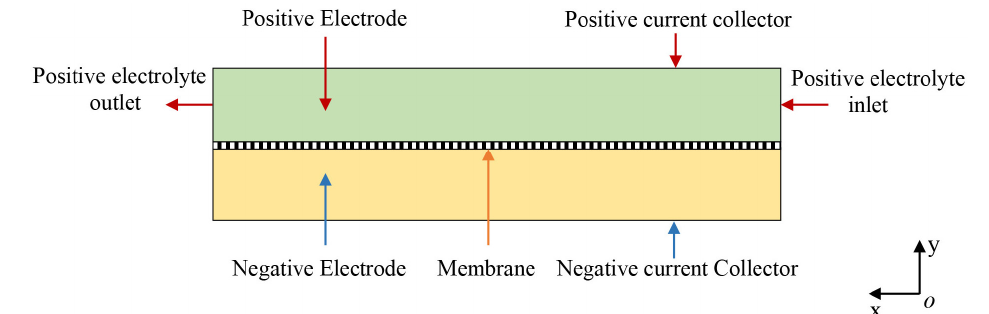
Figure 2. Schematic diagram of the model calculation area.